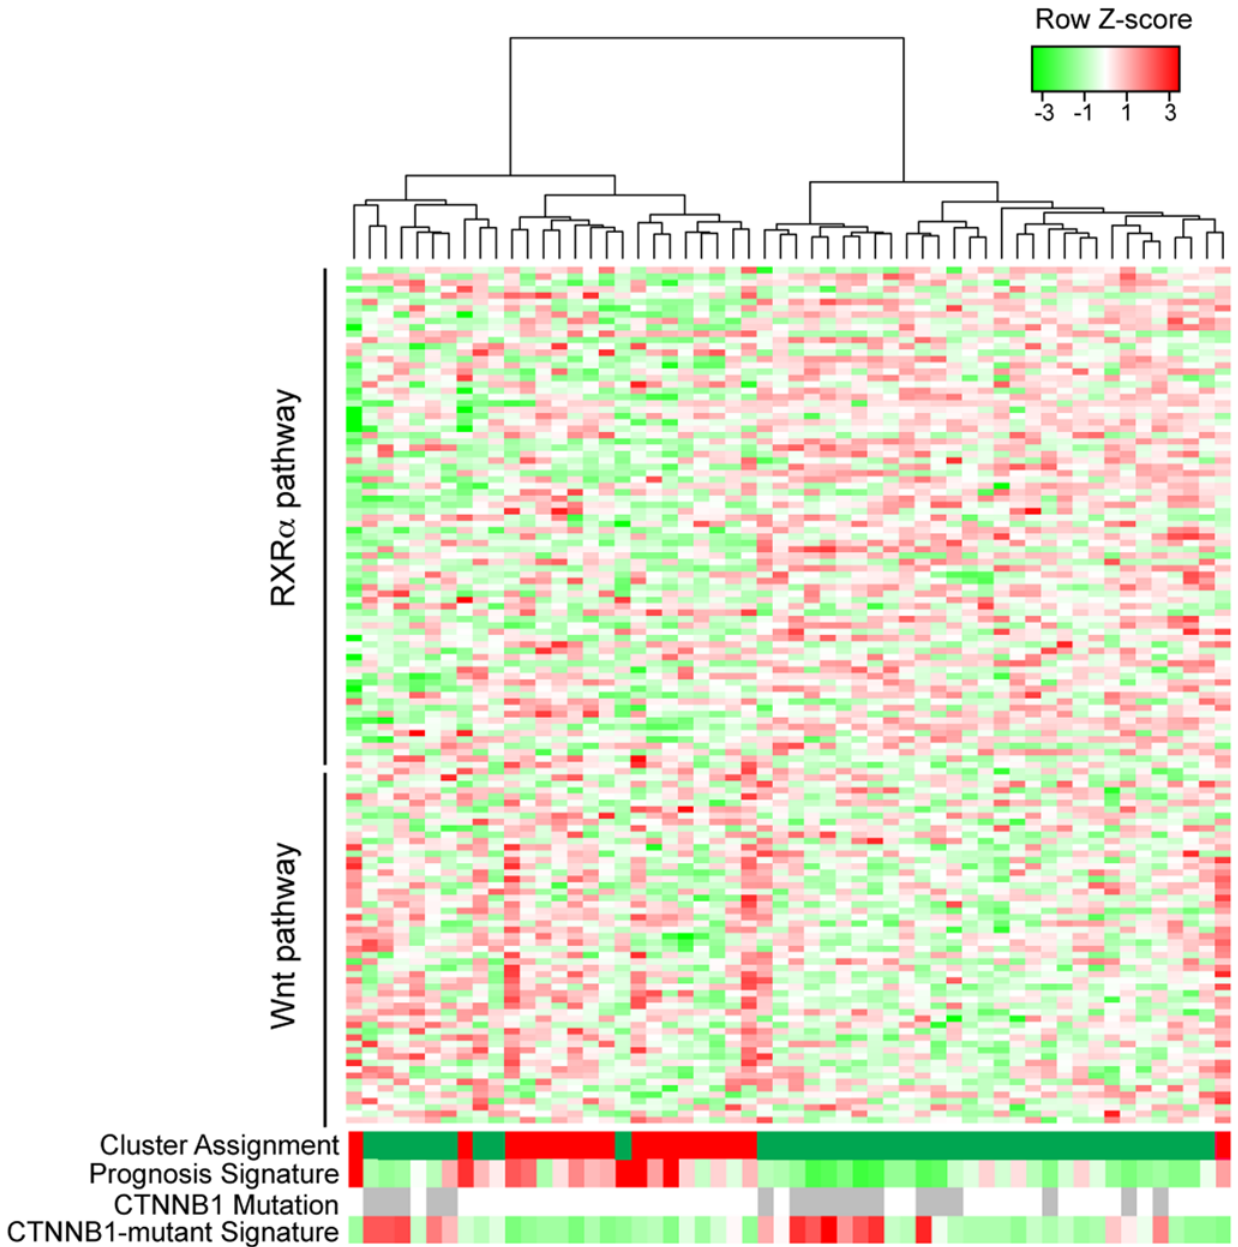
Fig 4. Classification of human HCC based on expression of RXR- α and Wnt pathway genes. HCC samples in the Boyault dataset[12] were clustered based on expression of 138 RXR- α and Wnt pathway genes. Beneath the heatmap are four rows, showing for each HCC sample (1) cluster assignment to the two major groups found by unsupervised clustering of all genes (2) relative prognosis based on the 65-gene signature of Kim et al.[24], ranging from red = poor, white = neutral, green = good; (3) grey bars indicate activating mutation in CTNNB1 ; (4) average expression of the 5 genes known to be overexpressed in CTNNB1 -mutant HCC cells; red = expression, green = less expression of the 5-gene signature associated with CTNNB1 mutation[12].